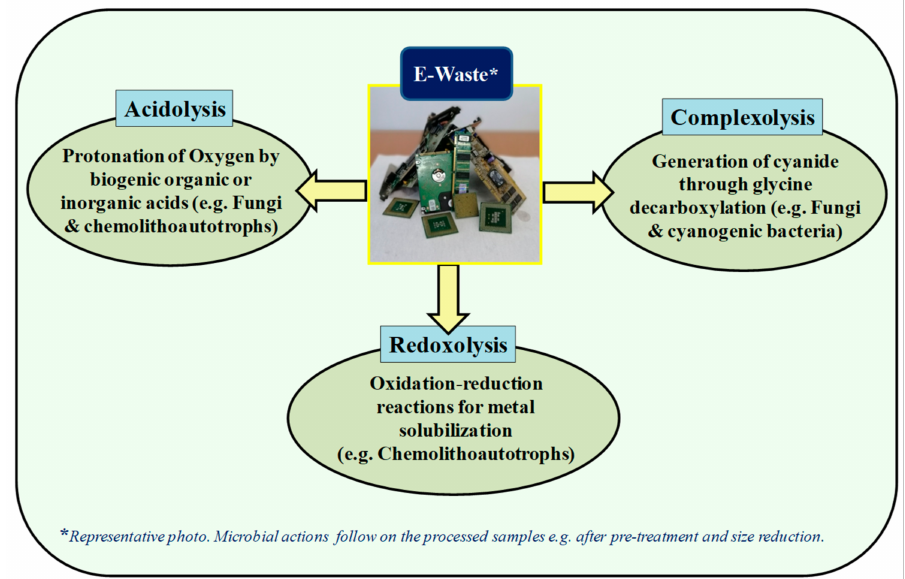
Figure 5. Microbial mechanisms involved in leaching of metals from